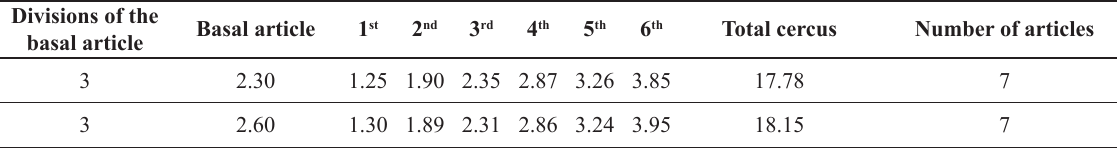
Table 4. Hubeicampa melissa Sendra & Lips gen. et sp. nov. (paratype MZB (MCNB) 2020-1165), cercal articles length and total length (units in mm), including number of articles of the cerci, basal article included, and division of basal article in secondary